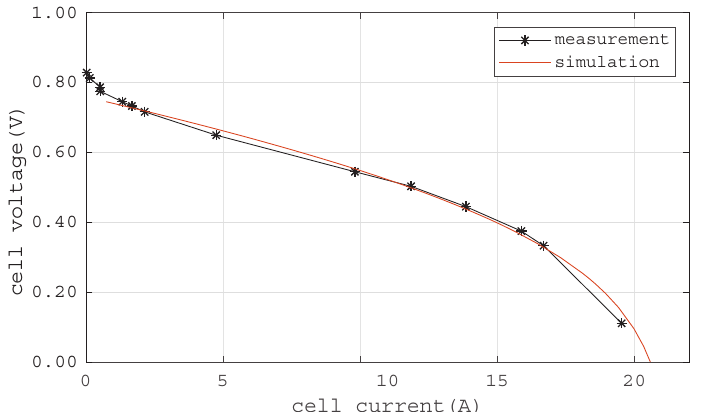
Figure 13. Comparison of measured and simulated polarization